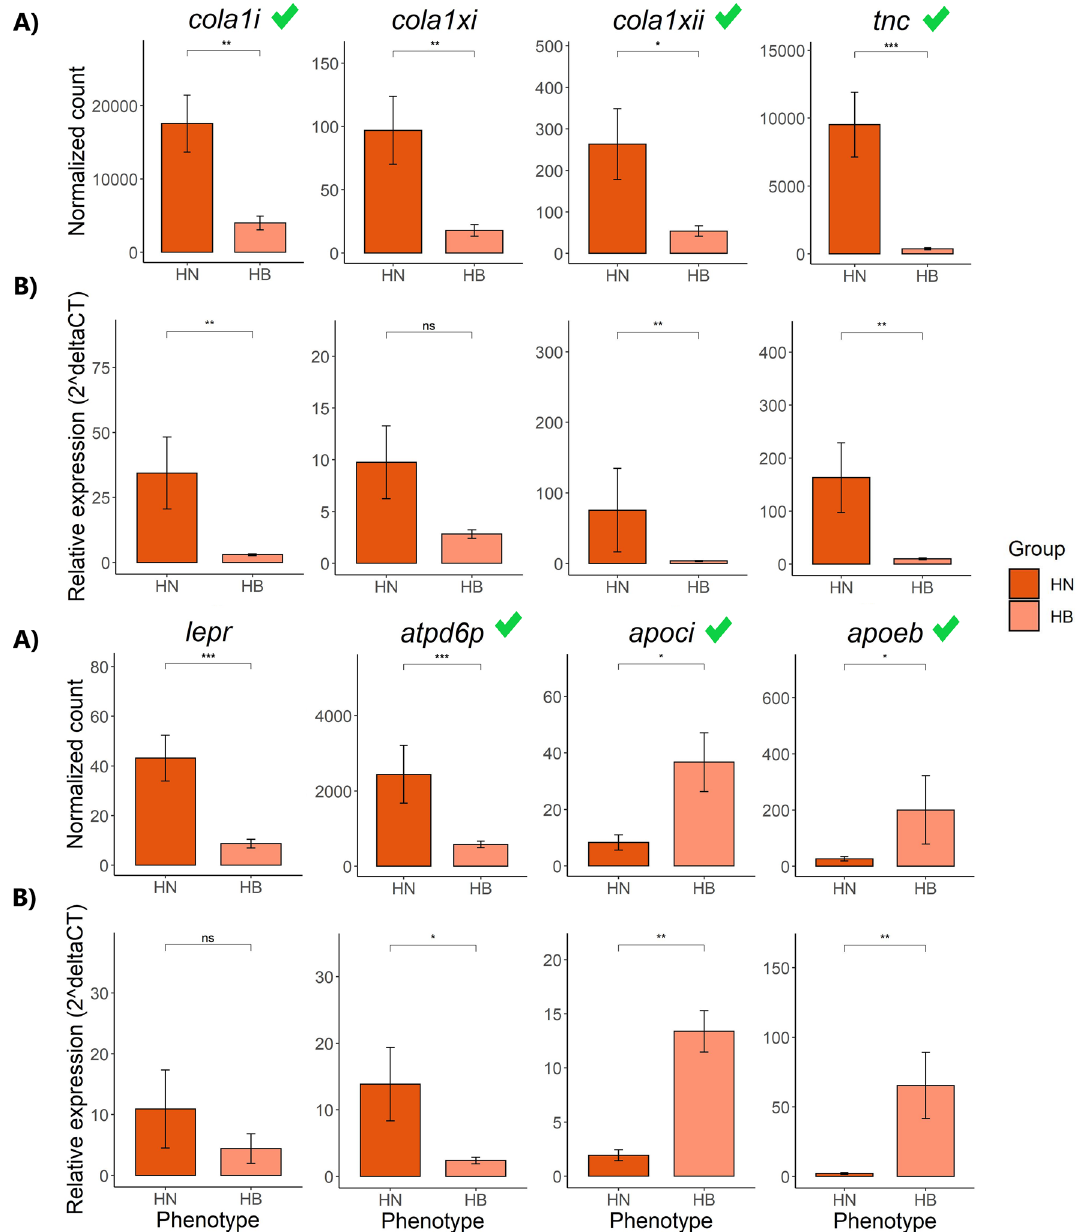
Figure 7. Differentially expressed genes in the FD region were validated using qPCR. Gene expression was calculated by normalized count in RNA-Seq ( A ) and relative expression in qPCR ( B ) in the comparisons of HN versus HB. An average normalized count or relative expression across transcripts is shown. Data is shown as Mean ± SD. (n = 5/sample type). Means with asterisks indicate significant differences ( P < 0.05). A green tick indicates a confirmed DEG by